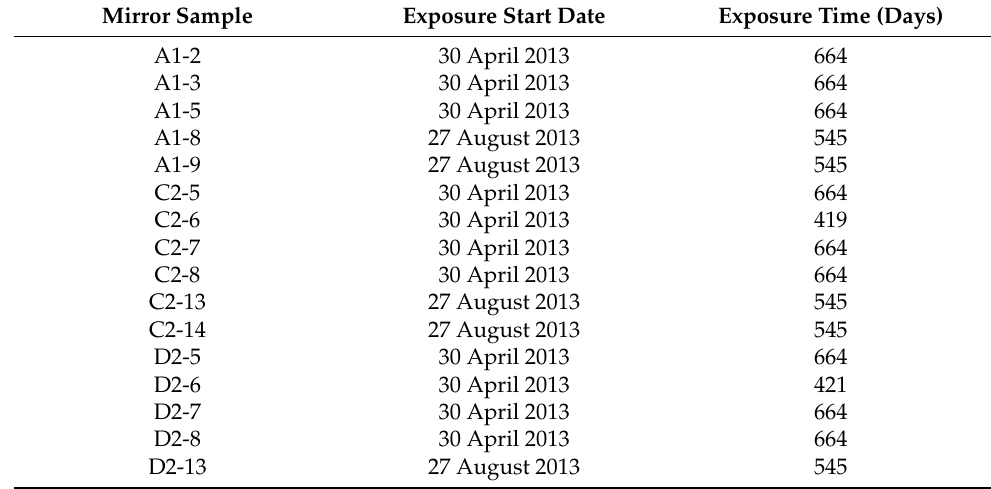
Table 6. Exposure start date and exposure time for mirrors tested at the desert